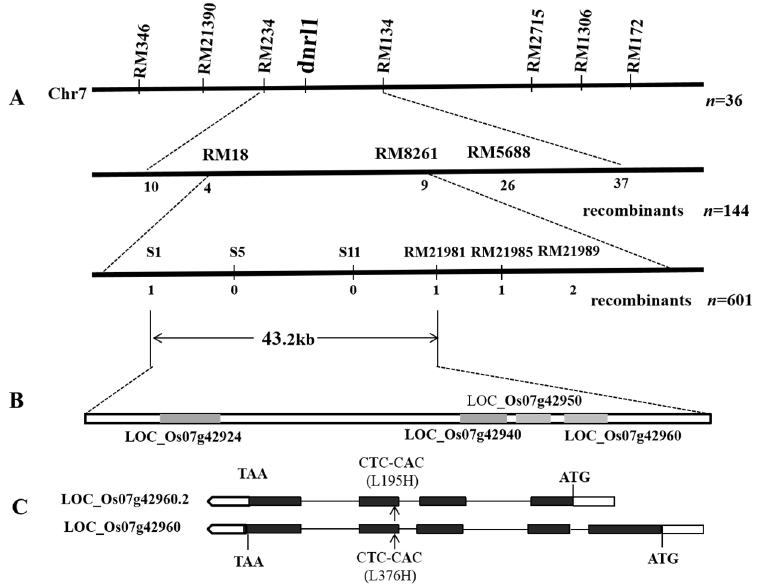
Figure 2. Map-based cloning of DNRL1 . ( A ) The DNRL1 locus was first mapped to chromosome 7 between markers RM234 and RM134, then narrowed down to an approximately 161 kb region between RM18 and RM8261 using 144 F 2 mutant type individuals from the cross of dnrl1 / Moroberekan. The DNRL1 locus was further delimited to a 43.2 kb region between markers S1 and RM21981 using 601 F 2 mutant type plants from the cross of dnrl1 / Moroberekan; ( B ) a total of 4 ORFs (in gray box) were predicted in the region; ( C ) the candidate gene has two transcripts, LOC_Os07g42960 and LOC_Os07g42960.2 and a single nucleotide substitution from T to A at position 1127 of LOC_Os07g42960 and position 584 of LOC_Os07g42960.2. CDS were identified, respectively. Black boxes: exons; blank box: untranslated region; line: intron; arrow indicates the mutant site. Markers used for fine mapping are listed in Table